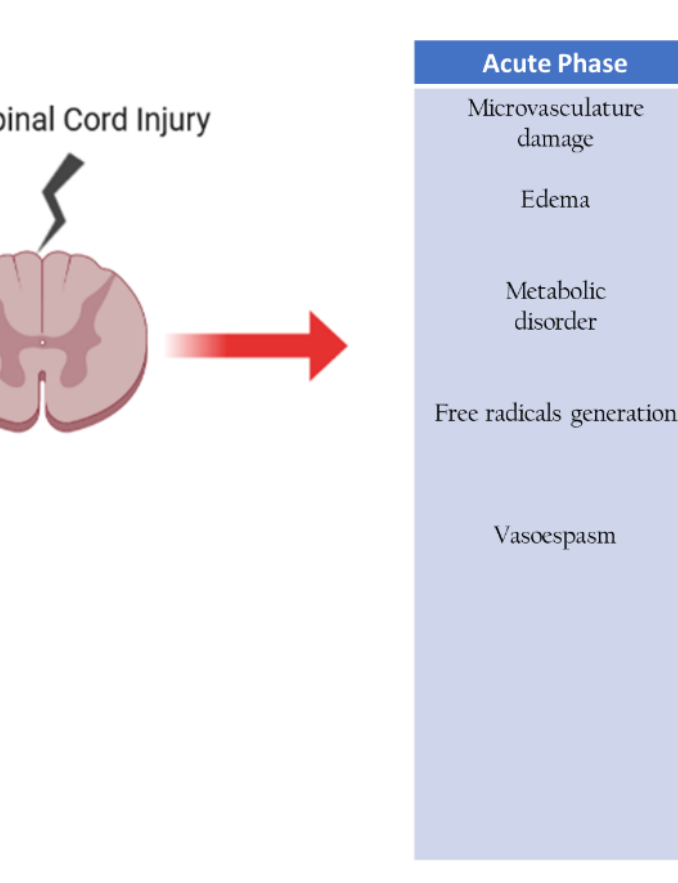
Figure 2. The processes that provokes secondary mechanisms of cell death in the spinal cord after injury.